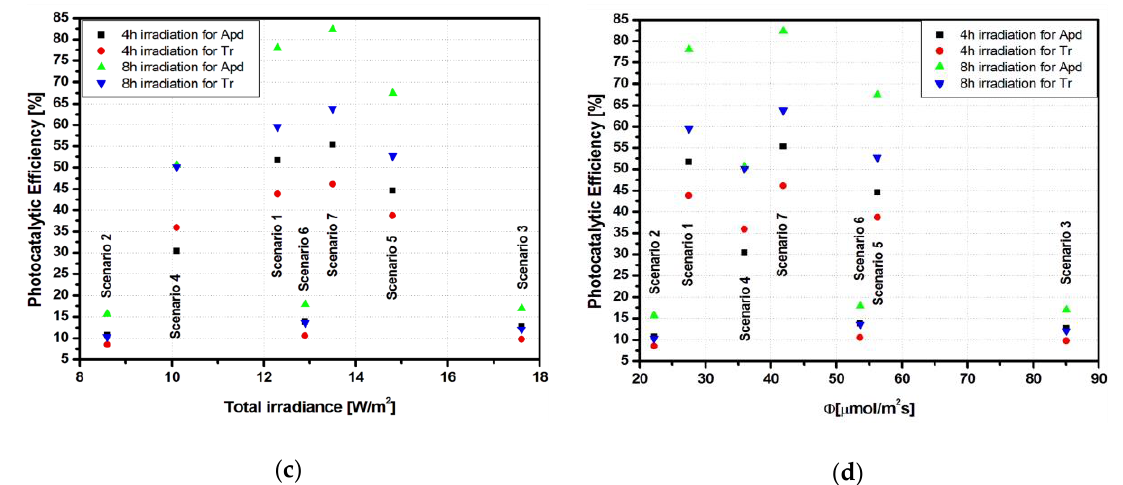
Figure 5. Photocatalytic parameters of the Ti_Al sample: ( a ) Tr photodegradation; ( b ) Apd photodegradation; ( c ) total irradiance vs. photocatalytic efficiency, and ( d ) photon flux vs. photocatalytic efficiency.